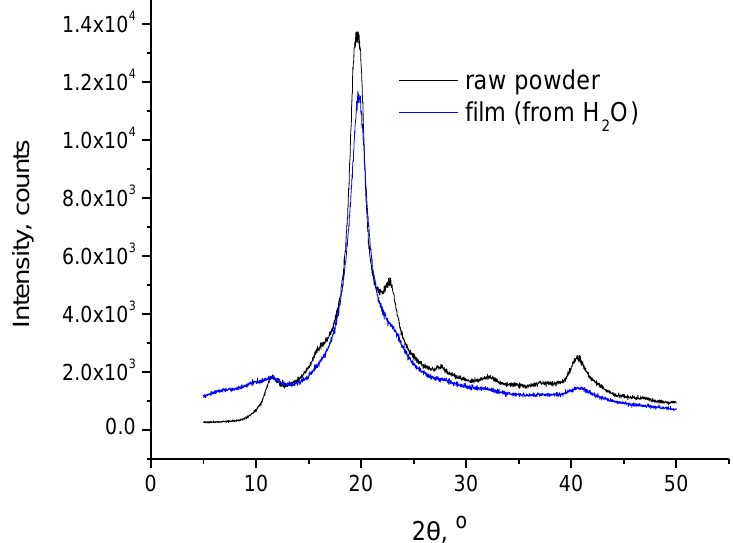
Figure 2. XRD patterns of PVA raw powder and film.